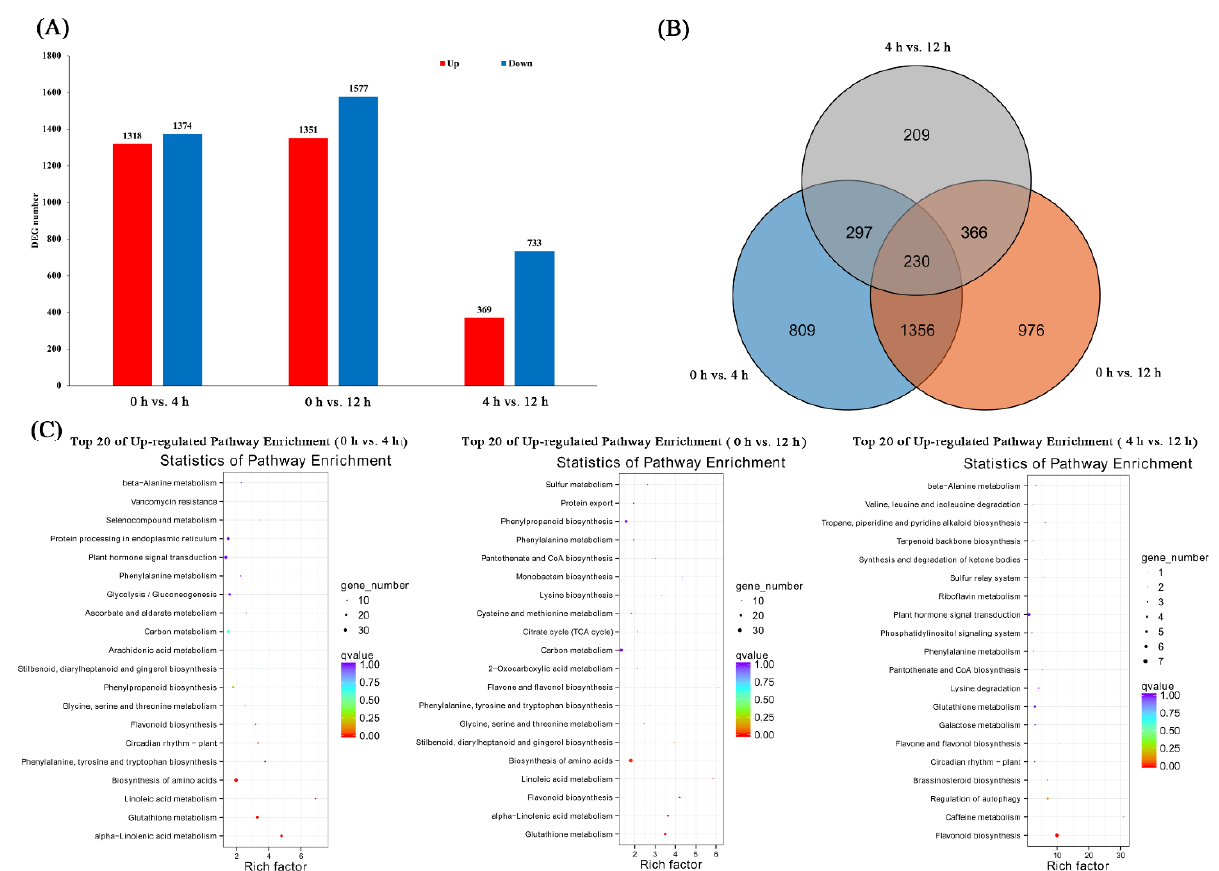
Figure 1. Differentially expressed genes (DEGs) at different time points under salt treatments. ( A ) Number of DEGs. ( B ) Venn diagram of DEGs. ( C ) Top 20 enriched pathways for overlapping salt responsive genes of 0 h vs. 4 h, 0 h vs. 12 h, and 4 h vs. 12 h.